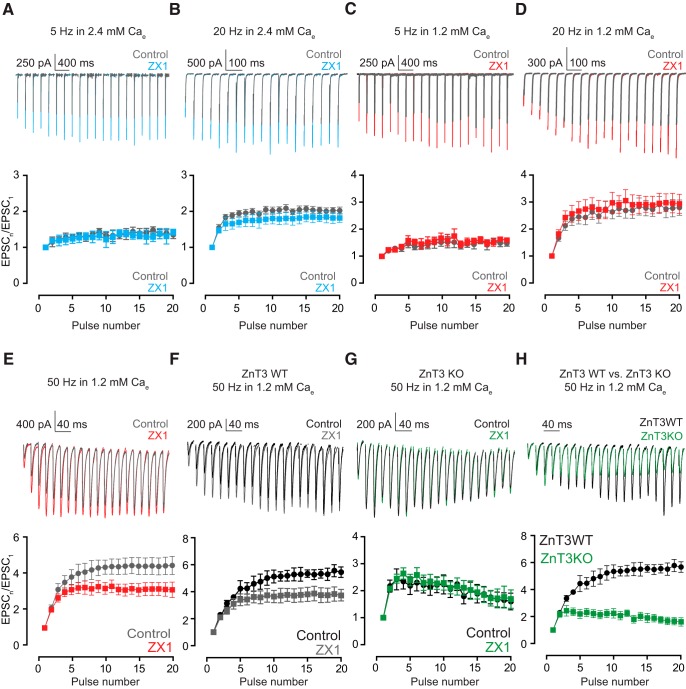
AMPA EPSC facilitation by synaptically released zinc is frequency, history, and Pr dependent. A, B, Upper panels, representative traces of AMPA EPSCs evoked by 20-pulse train at 5 Hz (A) and 20 Hz (B), before (gray) and after (color) 100 µM ZX1, in 2.4 mm external calcium. Lower panels, summary graphs showing average AMPA EPSC amplitudes during the 20-pulse train, normalized to EPSC amplitude of the first pulse, before (gray) and after (color) ZX1 application at 5 Hz (A) and 20 Hz (B), in 2.4 mm external calcium (ratio of the amplitude of 16–20 EPSC to first EPSC: 2.4 mm calcium: 5 Hz: control vs. ZX1, n = 5, p = 0.58; 20 Hz: control vs. ZX1, n = 5, p = 0.09). C–E, Upper panels, representative traces of AMPA EPSCs evoked by 20-pulse train at 5 Hz (C), 20 Hz (D), and 50 Hz (E), before (gray) and after (color) 100 µM ZX1, in 1.2 mm external calcium. Lower panels, summary graphs showing average AMPA EPSC amplitudes during the 20-pulse train, normalized to EPSC amplitude of the first pulse, before (gray) and after (color) ZX1 application at 5 Hz (C), 20 Hz (D), and 50 Hz (E) in 1.2 mm external calcium (ratio of the amplitude of 16–20 EPSC to first EPSC: 1.2 mm calcium: 5 Hz: control vs. ZX1, n = 5, p = 0.34; 20 Hz: control vs. ZX1, n = 5, p = 0.45; 50 Hz vs. ZX1, n = 10, p < 0.01). F, G, Upper panels, representative traces of AMPA EPSCs evoked by 50-Hz 20-pulse train, before (black) and after (color) 100 µm ZX1, in ZnT3WT (F) and ZnT3KO (G) mice. Lower panels, summary graphs showing average AMPA EPSC amplitudes during the 50-Hz 20-pulse train, normalized to EPSC amplitude of the first pulse, before (black) and after (color) ZX1 application, in ZnT3WT (F) and ZnT3KO (G) mice (ratio of the amplitude of 16–20 EPSC to first EPSC: ZnT3WT mice: 50 Hz control vs. ZX1, n = 6, p < 0.01; ZnT3KO mice: 50 Hz: control vs. ZX1, n = 5, p = 0.85). H, Upper panel, representative traces of peak-scaled AMPA EPSCs evoked by 50-Hz 20-pulse train in ZnT3WT (black) and ZnT3KO mice (green). Lower panel, summary graphs showing average AMPA EPSC amplitudes during the 50-Hz 20 pulse train, normalized to EPSC amplitude of the first pulse in control conditions, in ZnT3WT (black) and ZnT3KO (color) mice (ratio of the amplitude of 20 EPSC to first EPSC: ZnT3WT vs. ZnT3KO: control: 50 Hz, n = 5, p < 0.01). Values represent mean ± SEM. Detailed values and statistical tests: A, B, lower panels: ratio of the amplitude of 16–20 EPSC to first EPSC: 2.4 mm calcium: 5 Hz: control: 1.40 ± 0.12 vs. ZX1: 1.34 ± 0.15, n = 5, p = 0.58, F = 0.31, DFn = 1, DFd = 40; 20 Hz: control: 2.03 ± 0.09 vs. ZX1: 1.83 ± 0.14, n = 5, p = 0.09, F = 3.0, DFn = 1, DFd = 40; two-way ANOVA. C–E, lower panels: ratio of the amplitude of 16–20 EPSC to first EPSC: 1.2 mm calcium: 5 Hz: control: 1.54 ± 0.14 vs. ZX1: 1.61 ± 0.11, n = 5, p = 0.34, F = 0.9, DFn = 1, DFd = 40; 20 Hz: control: 2.78 ± 0.29 vs. ZX1: 2.94 ± 0.34, n = 5, p = 0.45, F = 0.56, DFn = 1, DFd = 40; 50 Hz: 4.44 ± 0.47 vs. ZX1: 3.14 ± 0.37, n = 10, p < 0.01, F = 22.59, DFn = 1, DFd = 90; two-way ANOVA. F, G, lower panels: ratio of the amplitude of 16–20 EPSC to first EPSC: ZnT3WT mice: 50 Hz: 5.580 ± 0.39 vs. ZX1: 3.96 ± 0.55, n = 6, p < 0.01, F = 28.37, DFn = 1, DFd = 50; ZnT3KO mice: control: 50 Hz: 1.71 ± 0.27 vs. ZX1: 1.74 ± 0.33, n = 5, p = 0.85, F = 0.04, DFn = 1, DFd = 40; two-way ANOVA. H, lower panel: ratio of the amplitude of 16–20 EPSC to first EPSC: ZnTWT vs. ZnT3KO: control: 50 Hz: 5.58 ± 0.39 vs. 1.71 ± 0.27, n = 5, p < 0.01, t = 8.15, df = 8; unpaired t-test.